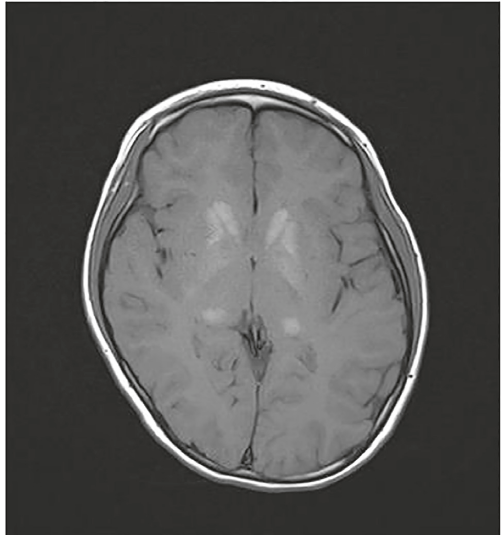
Figure 4: MRI brain showing T1 hyperintensities at caudate head, putamen, and thalamus caused by calcium.